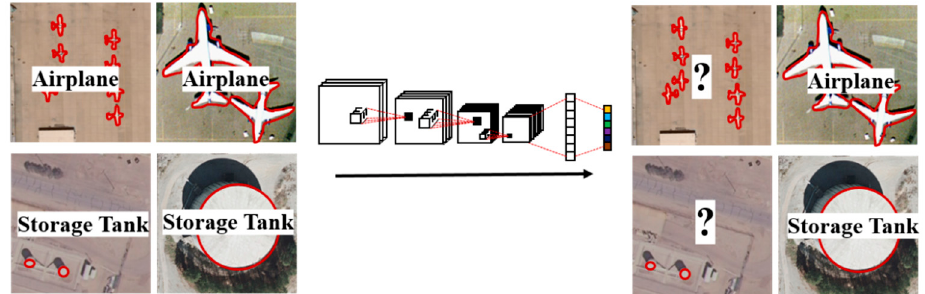
Figure 3. Object scale variation leading to difficulty in remote sensing scene classification.